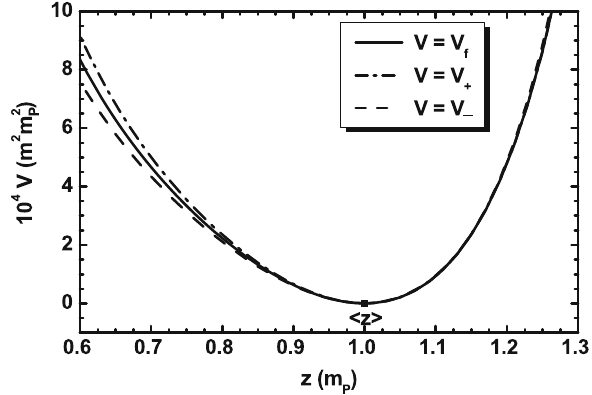
Fig. 3 The (dimensionless) SUGRA potential V / m 2 m 2 of z for ¯ z = 0 and the settings in columns A (solid line), C (dot-dashed line)andD(dashedline)ofTable1.Thevalue (cid:6) z (cid:7) = m P